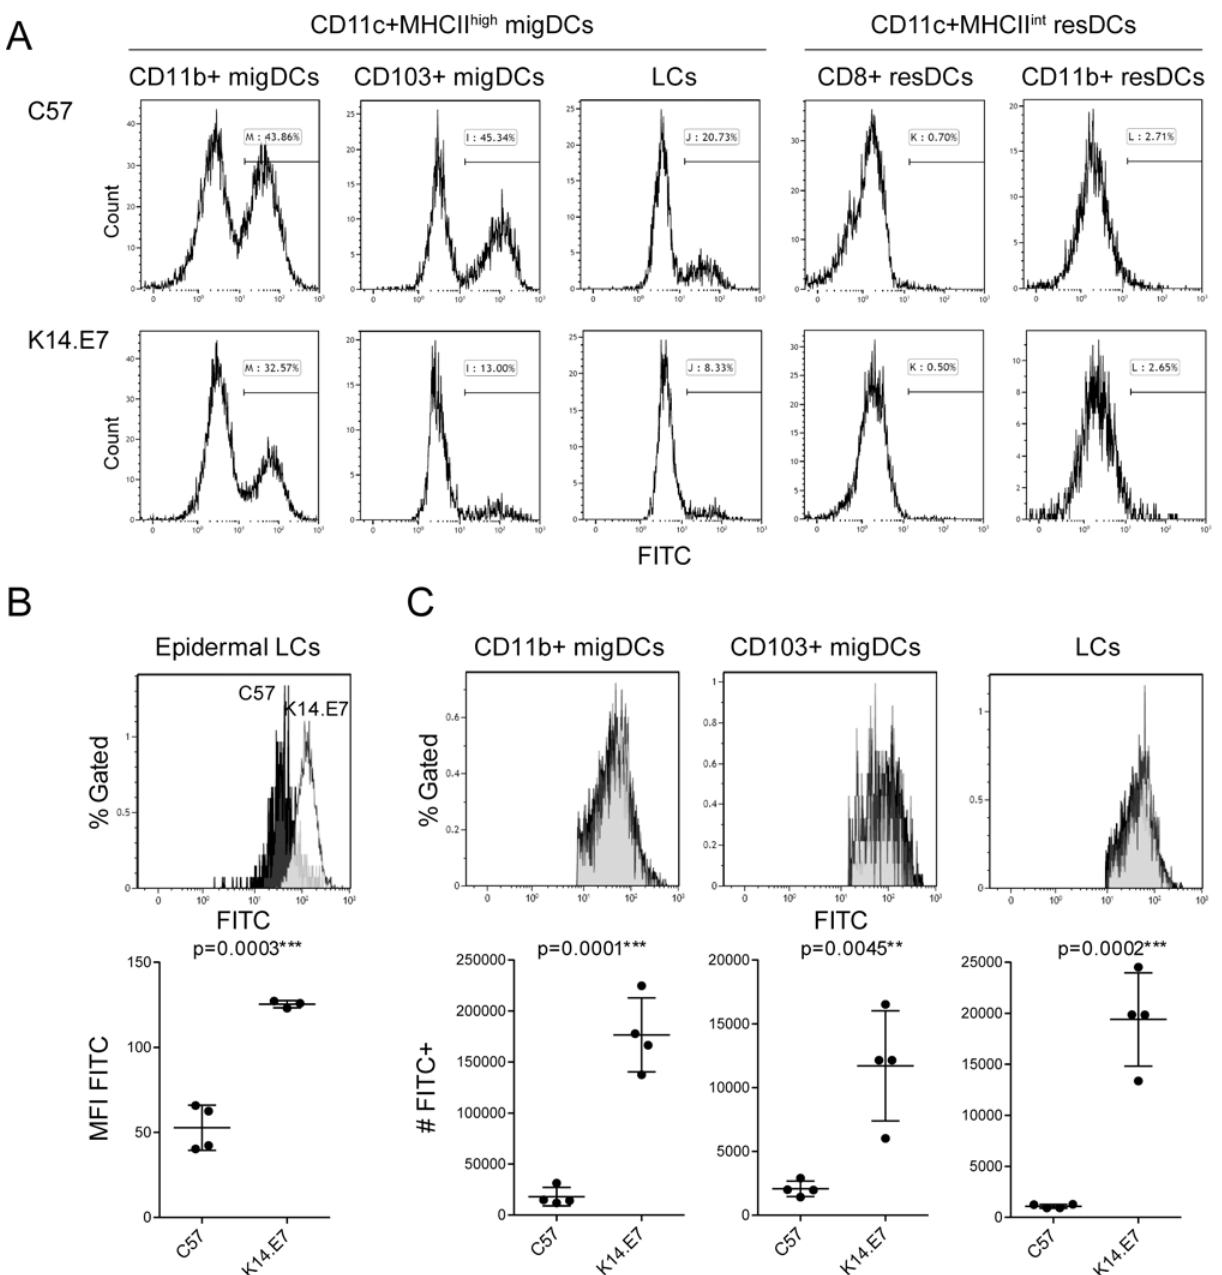
Fig 4. Skin-resident DCs of K14.E7 mice take up antigen and migrate to the draining lymph nodes. C57BL/6 and K14.E7 mice were painted with 100 μ l of 5mg/ml FITC dissolved in 1:1 acetone:dibutylphalate on shaved flanks and ears. 24 hours later, axillary and inguinal lymph nodes were analyzed by flow cytometry for presence of FITC + DC subsets. (A) FITC uptake by DC subsets in lymph nodes pre-gated according to Table 1 and S1 Fig. (B) MFI of FITC + LCs in the ear epidermis pre-gated according to Fig 1A. (C) MFI and total number of FITC + DCs in lymph node. Shown is one of two independent experiments, n =